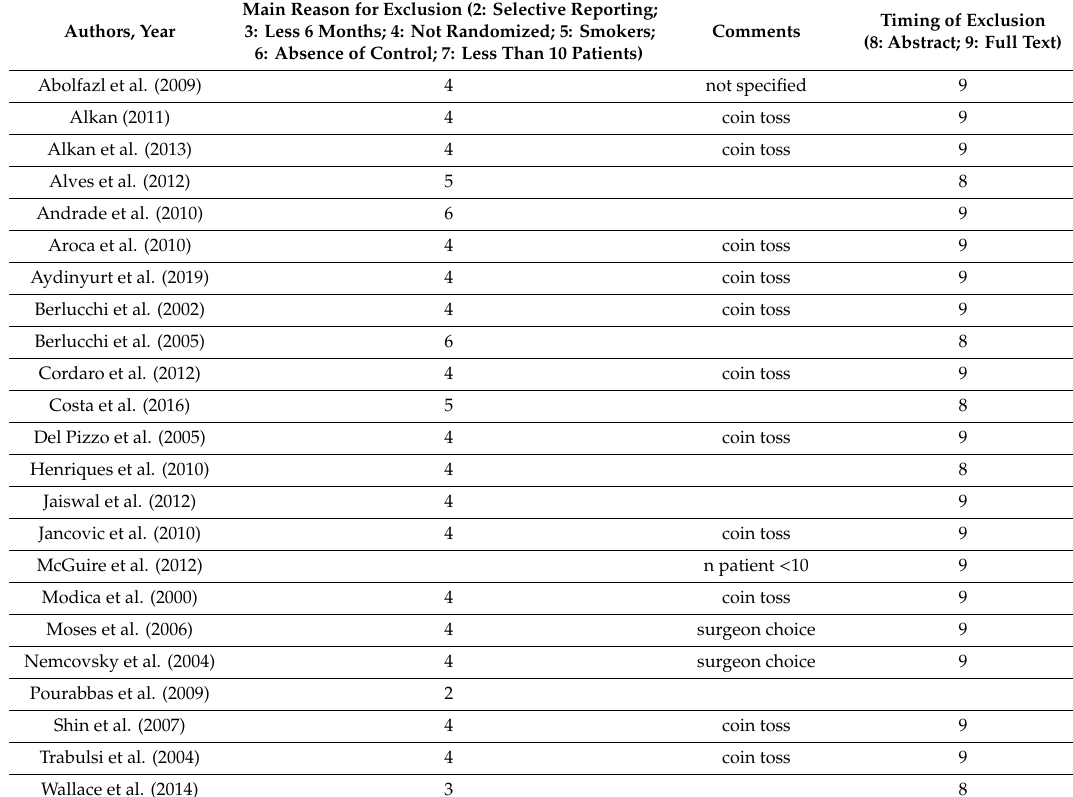
Table A1. Full text analysis: Reason for Exclusion and Timing of Exclusion.